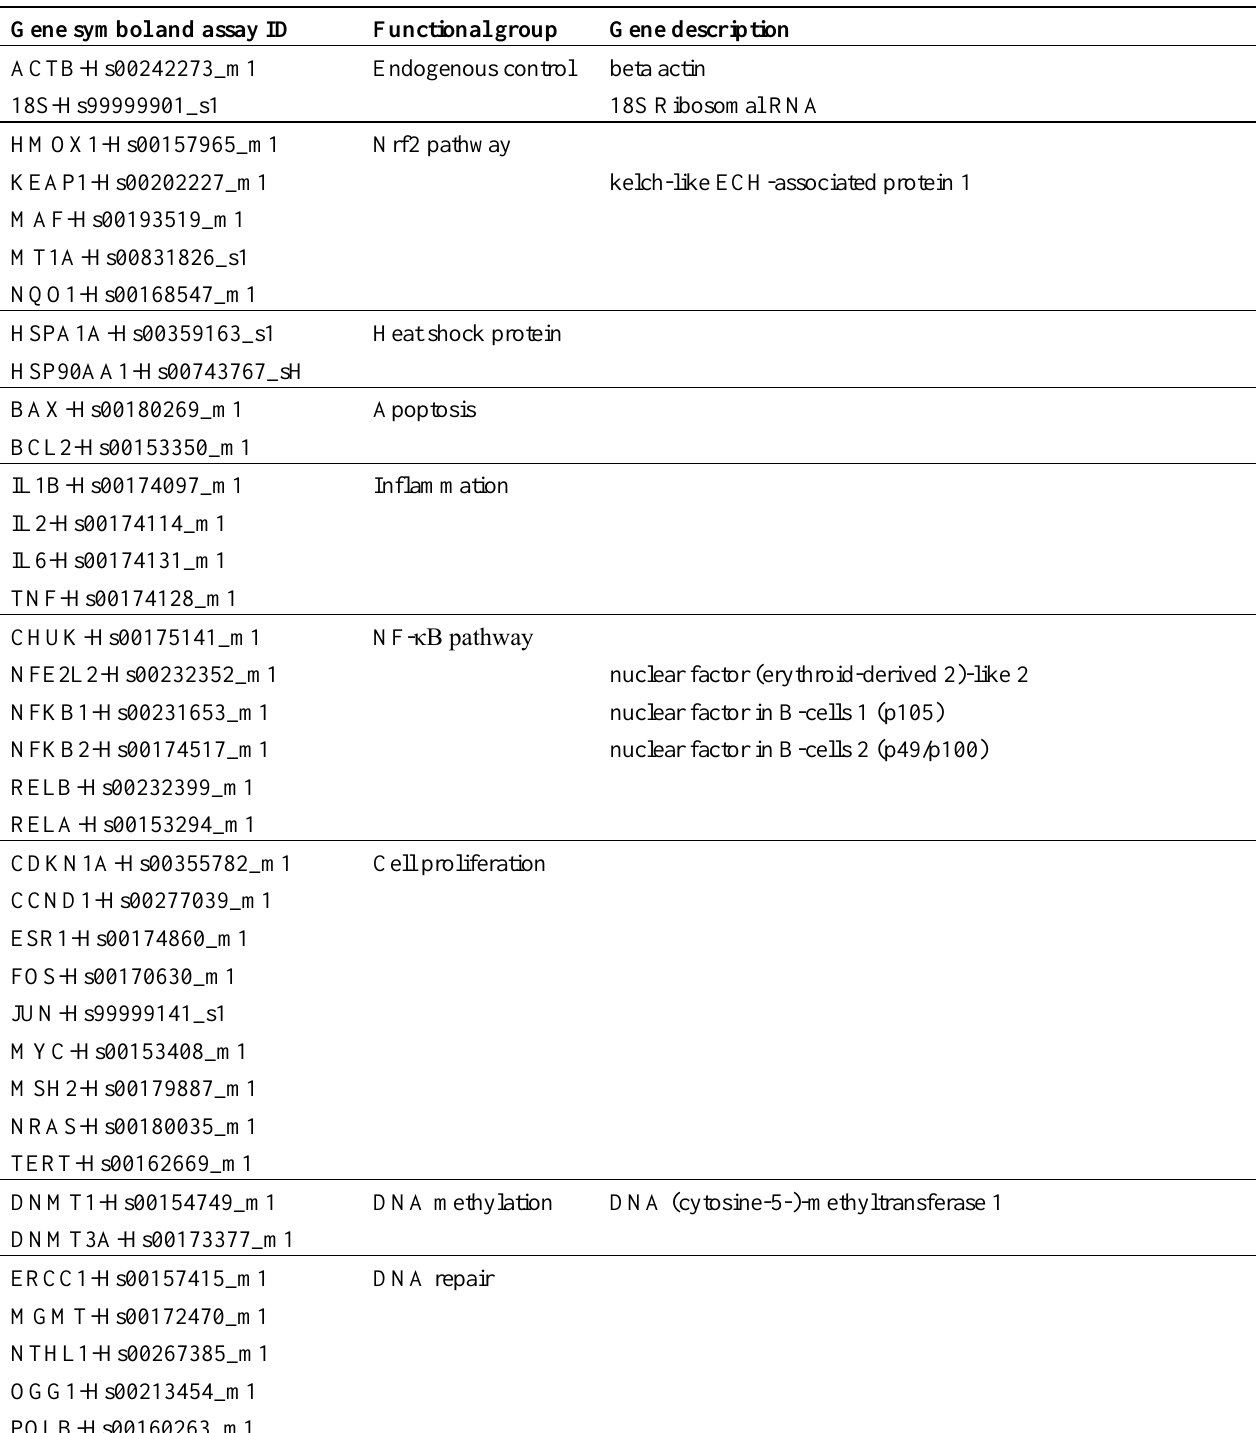
Table 1. Genes analyzed by